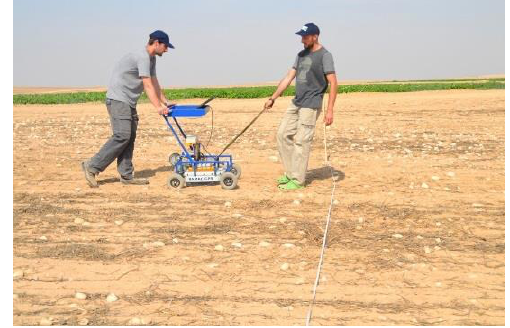
Figure 4. GPR cross-section field measurement in Gilat research